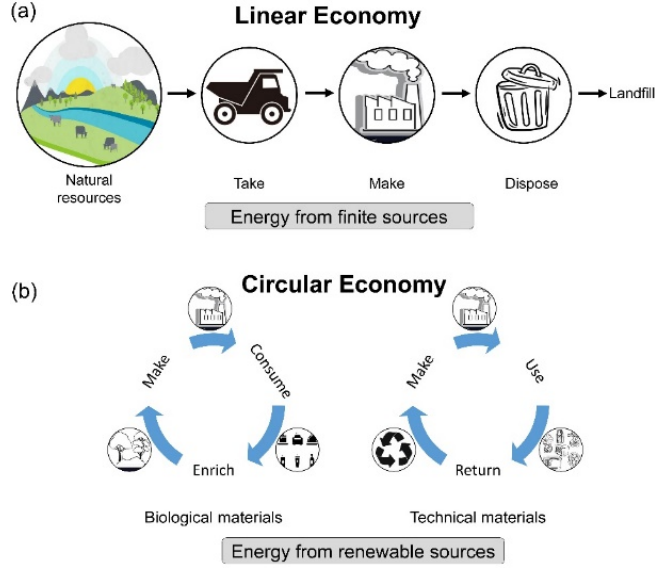
Figure 1. Recycling economy: ( a ) linear economy versus ( b ) circular economy.